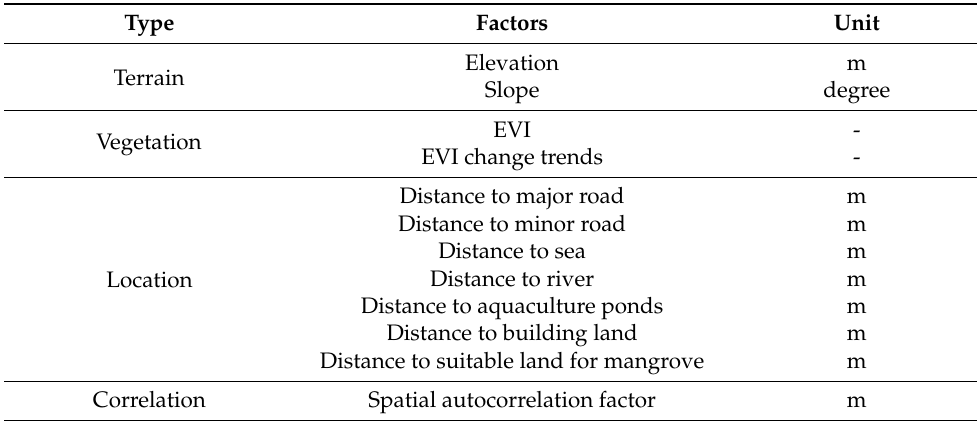
Table 1. The driving factor data used in this study.